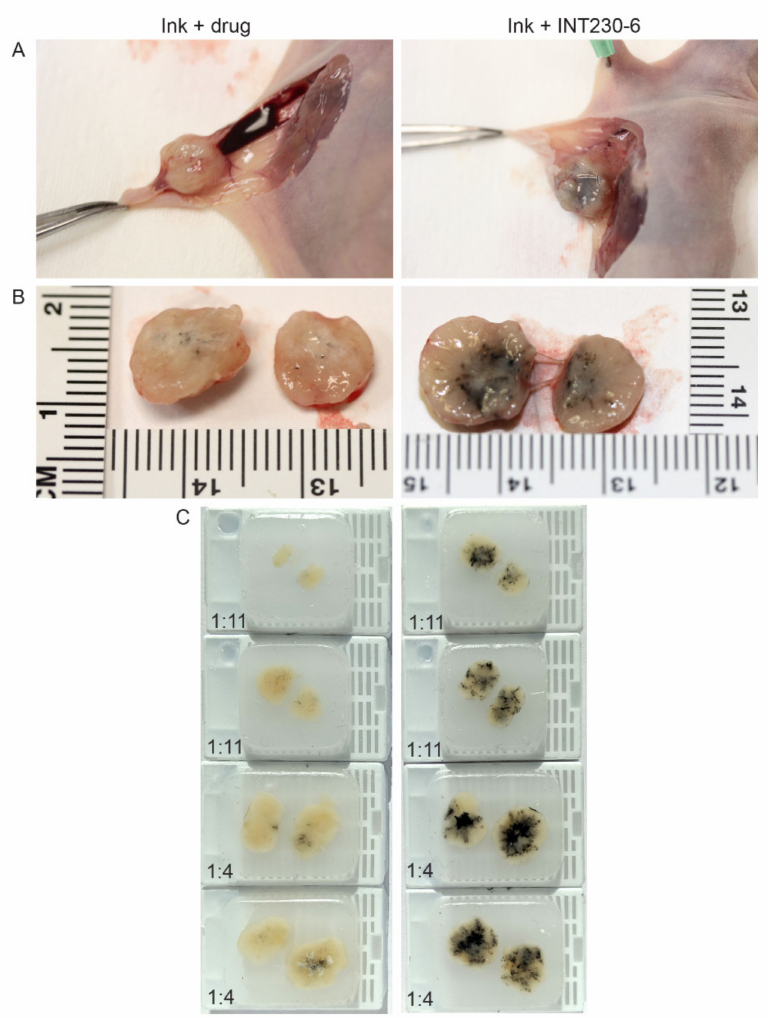
Figure 1. Comparison of dispersion of aqueous drug solutions containing -((2-hydroxybenzoyl)amino) octanoate (SHAO) with India Ink compared to aqueous vehicle with drug (cis) with Ink alone in BxPc3-luc2 pancreatic murine tumor xenografts. The images show unexcised ( A ) and excised tumors ( B ), bifurcated along the same plane, dosed with 0.075 mL (1:11) or 0.225 mL (1:4) of the INT230-6 formulation (which contains the enhancer) or drug control administered intratumorally over 90 s to > 500-mm 3 tumors. ( C ) Para ffi n blocks were made from the injected tumors. Caliper measurements of the longest axis of the stained region were taken to estimate the degree of ink dispersion (INT230-6: mean 8.25 mm vs. drug alone: 2.8 mm p < 0.0002).